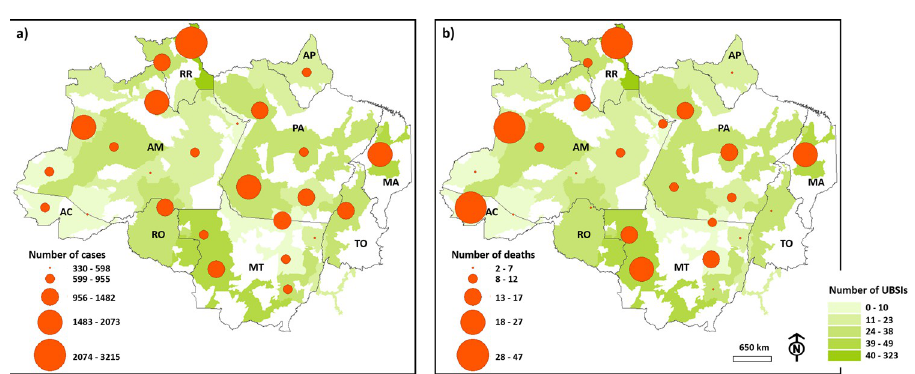
Fig 2. The number of COVID-19 cases (a) and deaths (b) of indigenous people in different Special Indigenous Health Districts (DSEIs) in Brazil’s Legal Amazon (BLA), depending on the number of indigenous primary healthcare units (UBSIs). The letters indicate the states in which the districts are located: RR = Roraima, AP = Amapa´, MA = Maranh ã o, PA = Para´, AM = Amazonas, AC = Acre, RO = Rondoˆnia, MT = Mato Grosso, and TO = Tocantins. Base layer obtained from: https://www.gov.br/funai/pt-br/atuacao/terras-indigenas/geoprocessamento-e-mapas.